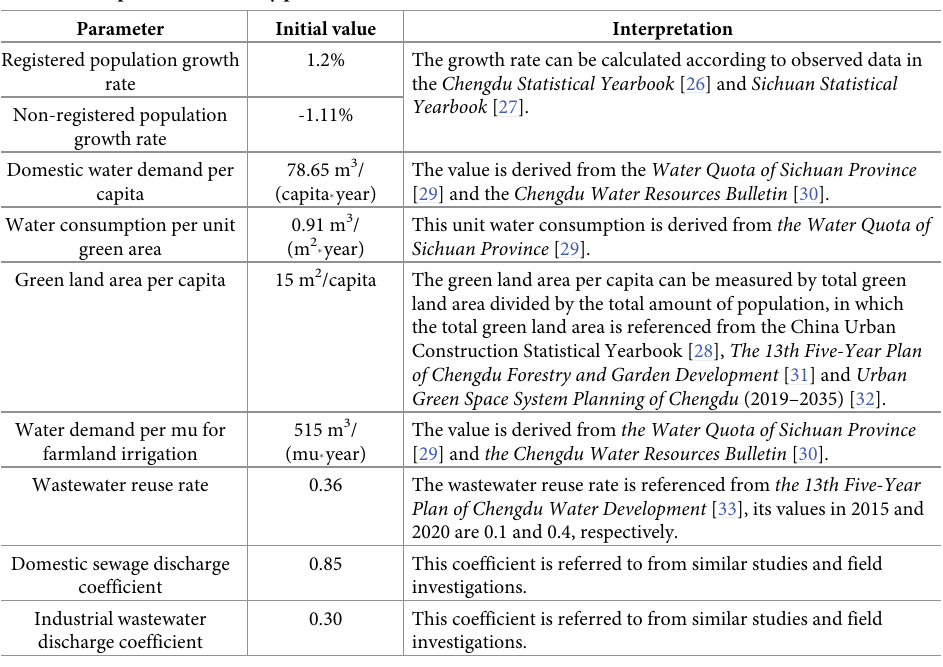
Table 1. Interpretation of the key